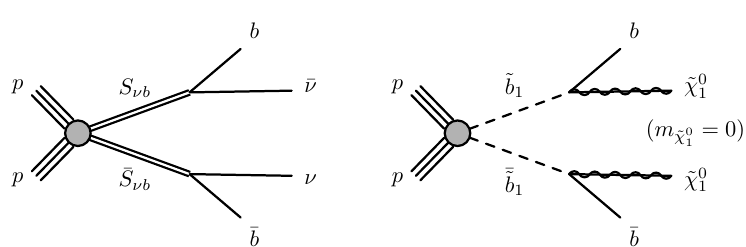
(cid:22) S Figure 7 . Diagrams for the process pp ! S ! ( b (cid:22) (cid:23) )((cid:22) b(cid:23) ) (left) and the corresponding SUSY (cid:23)b (cid:23)b (cid:22)~ )((cid:22) b ~ (cid:31) 0 process pp ! ~ b 1 b 1 ! ( b ~ (cid:31) 0 ) (right). For massless neutralinos the (cid:12)nal-states and kinematic 1 1 distributions of the two processes are identical. Similar identi(cid:12)cations can be made for other S (cid:23) q and squark searches. Here the \1" subscripts are the usual SUSY notation for lightest b -squark and lightest